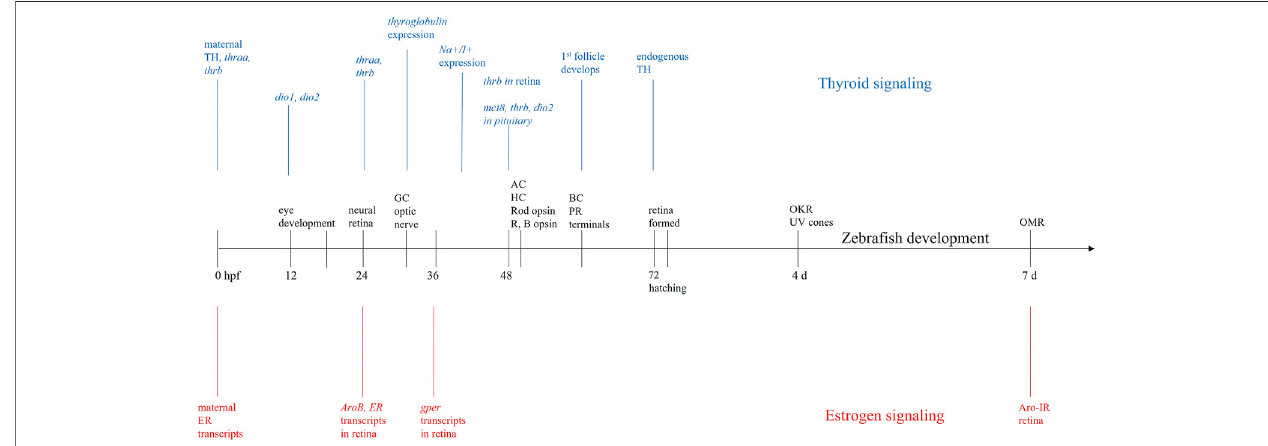
FIGURE 1 | Developmental timeline. Sequence of events in zebra fi sh eye and retinal development (black) beginning at fertilization (0 h postfertilization — hpf) and continuing until 7 days (days) postfertilization. During this time, maternally derived transcripts for estrogen receptors (ER — red) and maternally derived thyroid hormones (TH — blue) are present in yolk. At 24 hpf, when neural retina is developing, expression of ER and aromatase ( AroB ) are present in retina, and expression of the genes for both thyroid receptors ( thraa, thrb ) begins. Expression of G-protein coupled ER ( gper ) begins ~36 hpf; at 48 hpf thrb is expressed in retina. At hatching (72 hpf), there is endogenous production of both TH and estrogen. The overlap and concurrent development of thyroid, estrogen, and retinal development, suggests these hormones are important for proper retinal/visual system development. GC = ganglion cell, AC = amacrine cell, HC = horizontal cell, R = red cone, B = blue cone, BC = bipolar cell, PR = photoreceptor, OKR = optokinetic response, OMR = optomotor